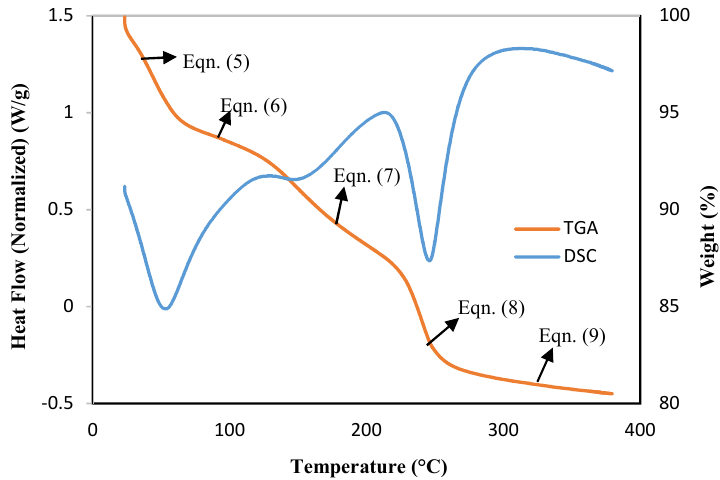
Figure 6. TGA-DSC curve for REF residue from Stage 3.